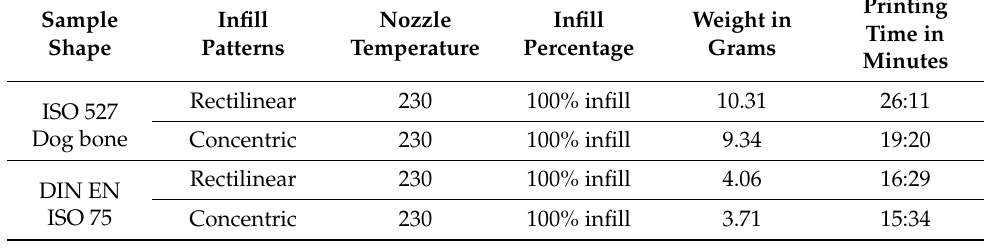
Table 1. Printing parameters used in the experiments.